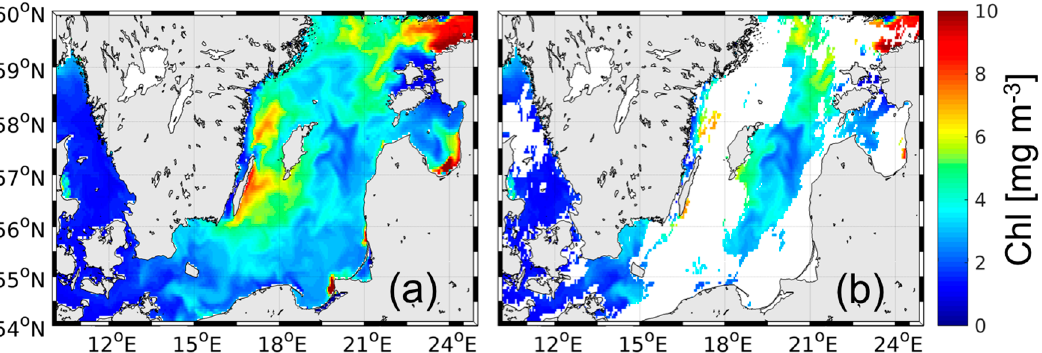
Figure 2. Example chlorophyll-a concentration (Chl) maps: ( a ) As obtained from the HBM HBO model for the 1 May 2016 at 12:00 local time; and ( b ) after the application of cloud masks (in white) by SEVIRI imager at the same hour.